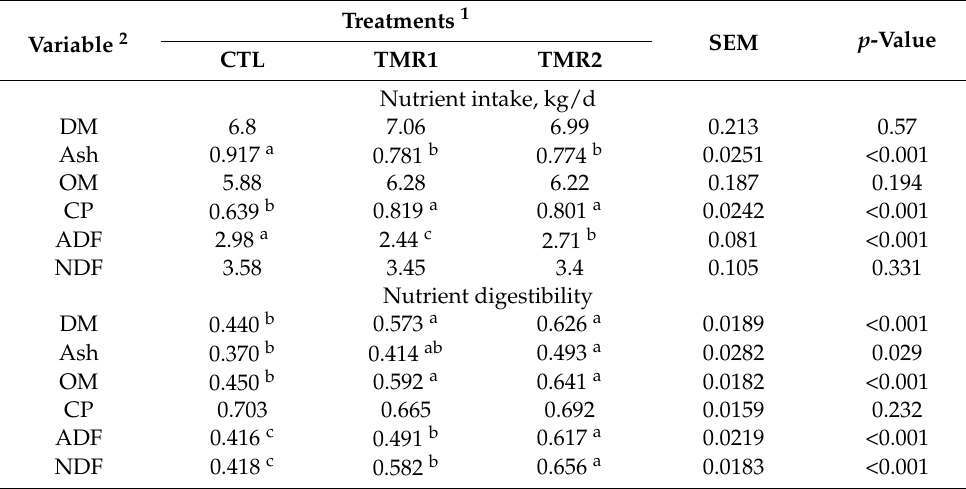
Table 6. Intake and apparent total tract digestibility of nutrients.